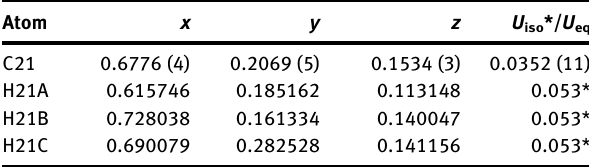
As shown in Figure (part a), there is a crystallograph- ically independent Eu 3 + named Eu1. The adjacent Eu 3 + is bridged by eight oxygen atoms from four terephthalato ligands and one DMF ligand to form a binuclear Eu2 unit, where the distance between Eu 3 + and Eu 3 + in the binuclear Eu unit is about 4.007 Å (see part b of the fi gure). In this 2 structure, the average Eu – O bond length is about 2.532 Å. In addition, the adjacent dinuclear Eu units are connected 2 to each other by bridging terephthalato ligands to expand into a three-dimensional framework structure. The voids of the structure are fi lled with dimethylaminium cations and role in balancing the charge.